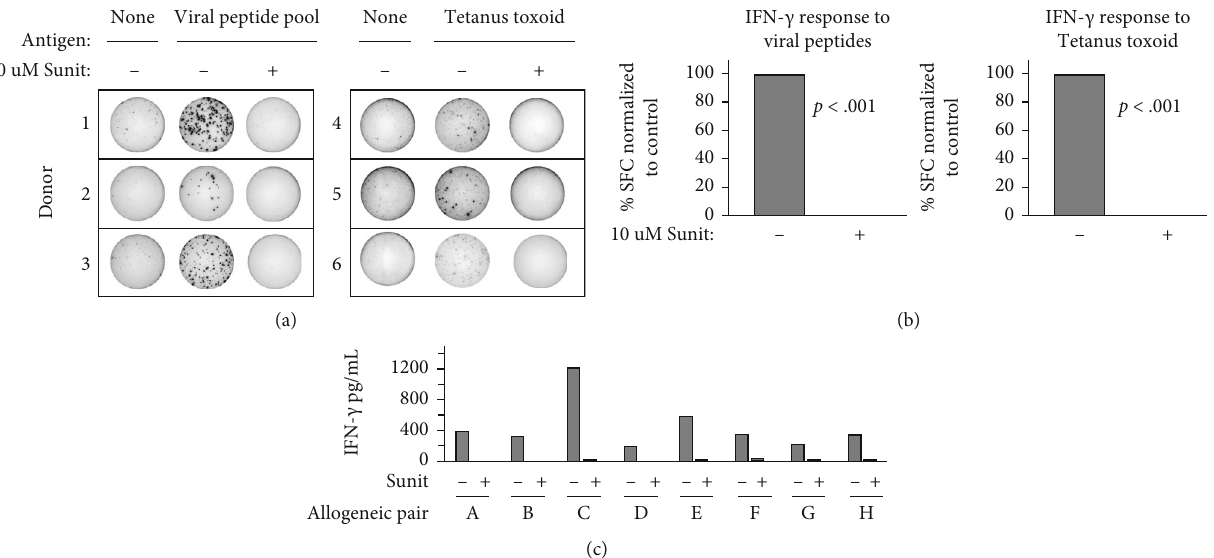
Figure 6: Sunitinib suppresses interferon-gamma secretion by stimulated T cells. (a) Example IFN- γ ELISPOT wells from individual healthy donor PBMCs stimulated with a mixture of common viral peptide recall antigens (left panel) or tetanus toxoid (right panel) in the presence or absence of sunitinib ( “ sunit ” ; 10 μ M). (b) Composite analysis of each of the 3 donors for viral recall peptides (left panel) and 3 donors for tetanus toxoid (right panel). Statistical analysis by one-way ANOVA indicated a signi fi cant di ff erence between sunitinib-treated and sunitinib-untreated groups. (c) IFN- γ ELISA analysis of 72-hour culture supernatants from 8 unique allogeneic MLRs (A – H) where activated dendritic cells (DC) and lymphocyte-rich elutriation fractions were cocultured at 1:40 stimulator:responder ratios in the presence or absence of 10 μ M